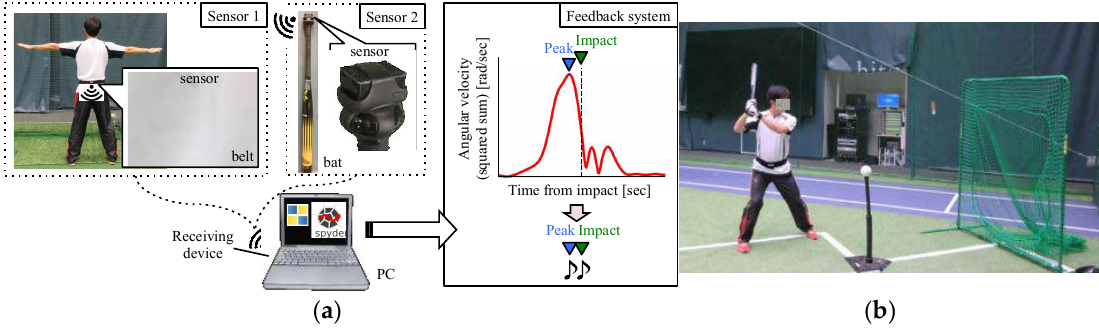
Figure 4. ( a ) Schematic illustration of the sonification system; ( b ) Experimental scenery (Tee).